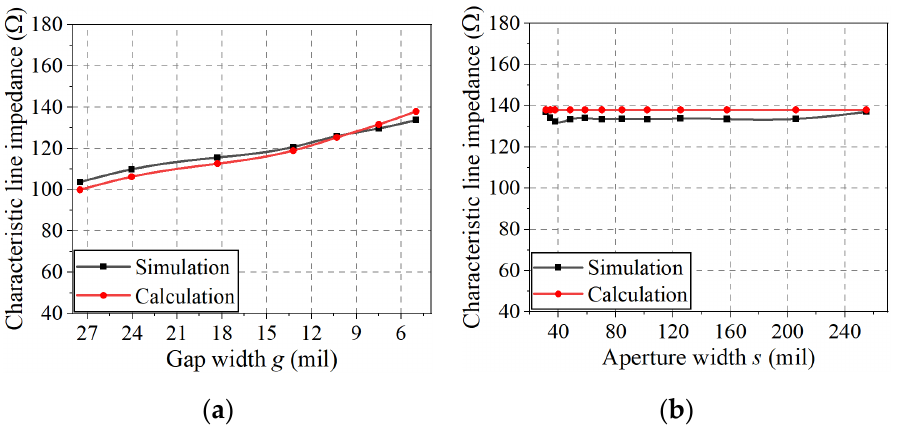
Figure 12. Calculated and EM-simulated characteristic line impedances of the DL-to-CPS transition: ( a ) BB ′ to CC ′ , ( b ) CC ′ to DD ′ .